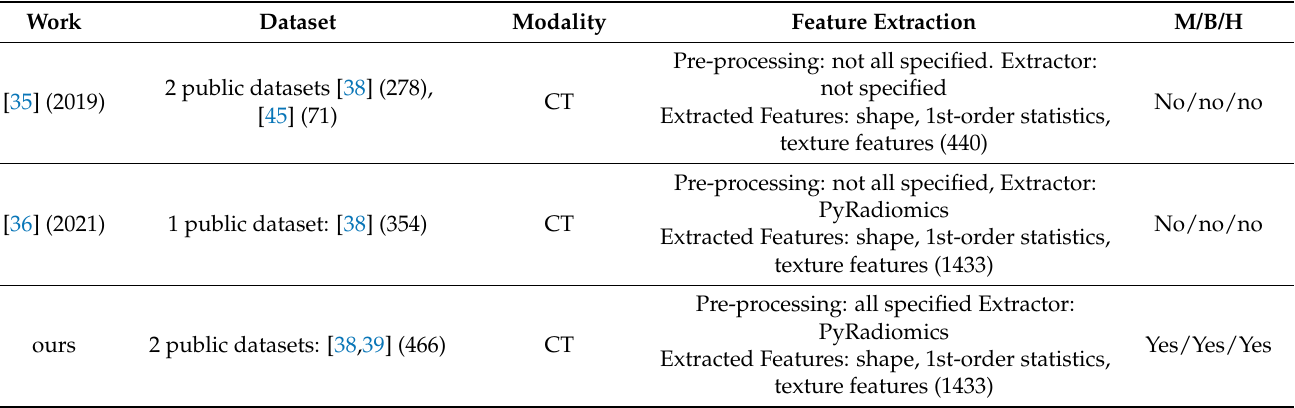
Table 2. Multiclass classification studies. M: multicenter, B: batch analysis, and H: harmonization. The number in the round brackets in the dataset column refers to the number of patients that were involved after a selection from the total available